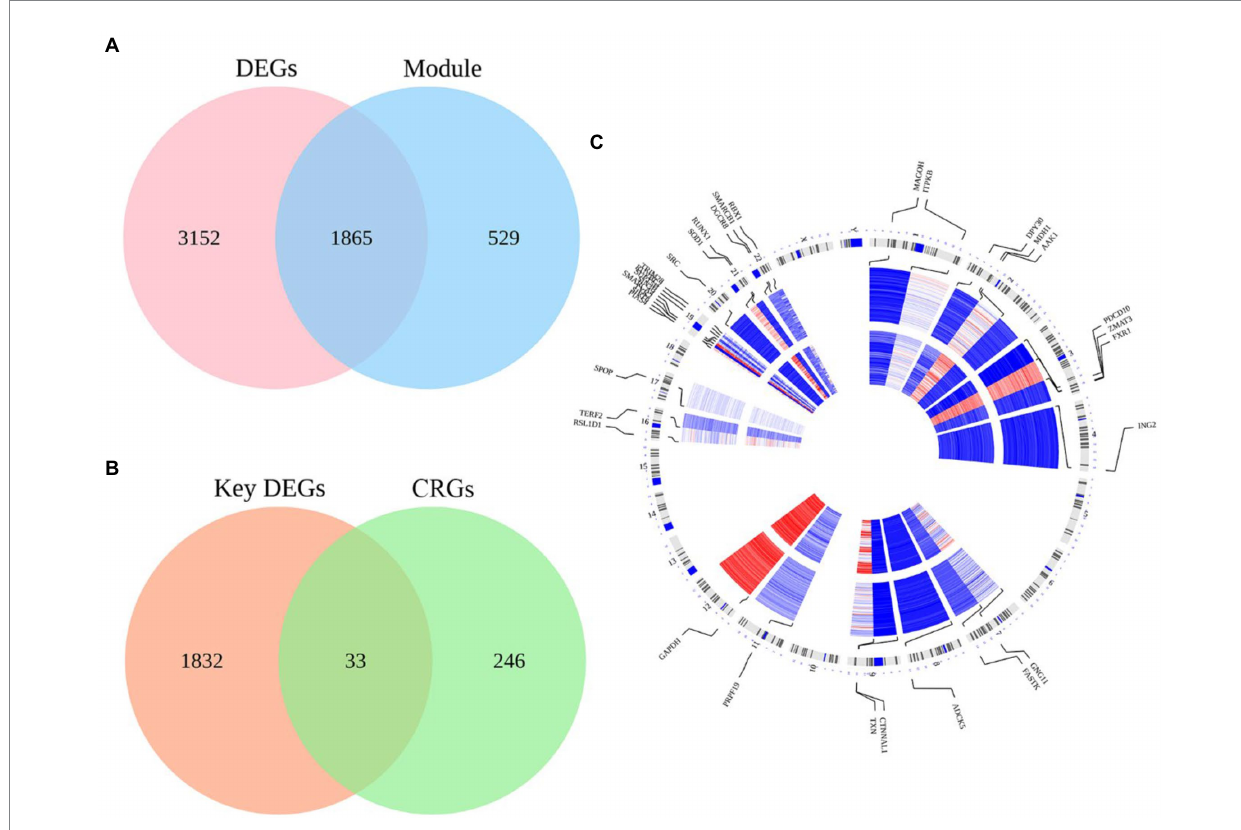
FIGURE 3 The intersection of MCI-related modules and cellular senescence-related genes as well as their locations on chromosomes. (A) There were 5,017 DEGs in the GSE63060 dataset and 2,394 genes in the blue module of the GSE63060 dataset, and 1865 genes were obtained as key DEGs by overlapping the two datasets. (B) There were 1865 key DEGs and 279 cellular senescence-related genes (CRGs) from Cell Age database, and 33 genes were obtained as CS-DEGs by overlapping the two datasets. (C) Chromosome locations of the 33